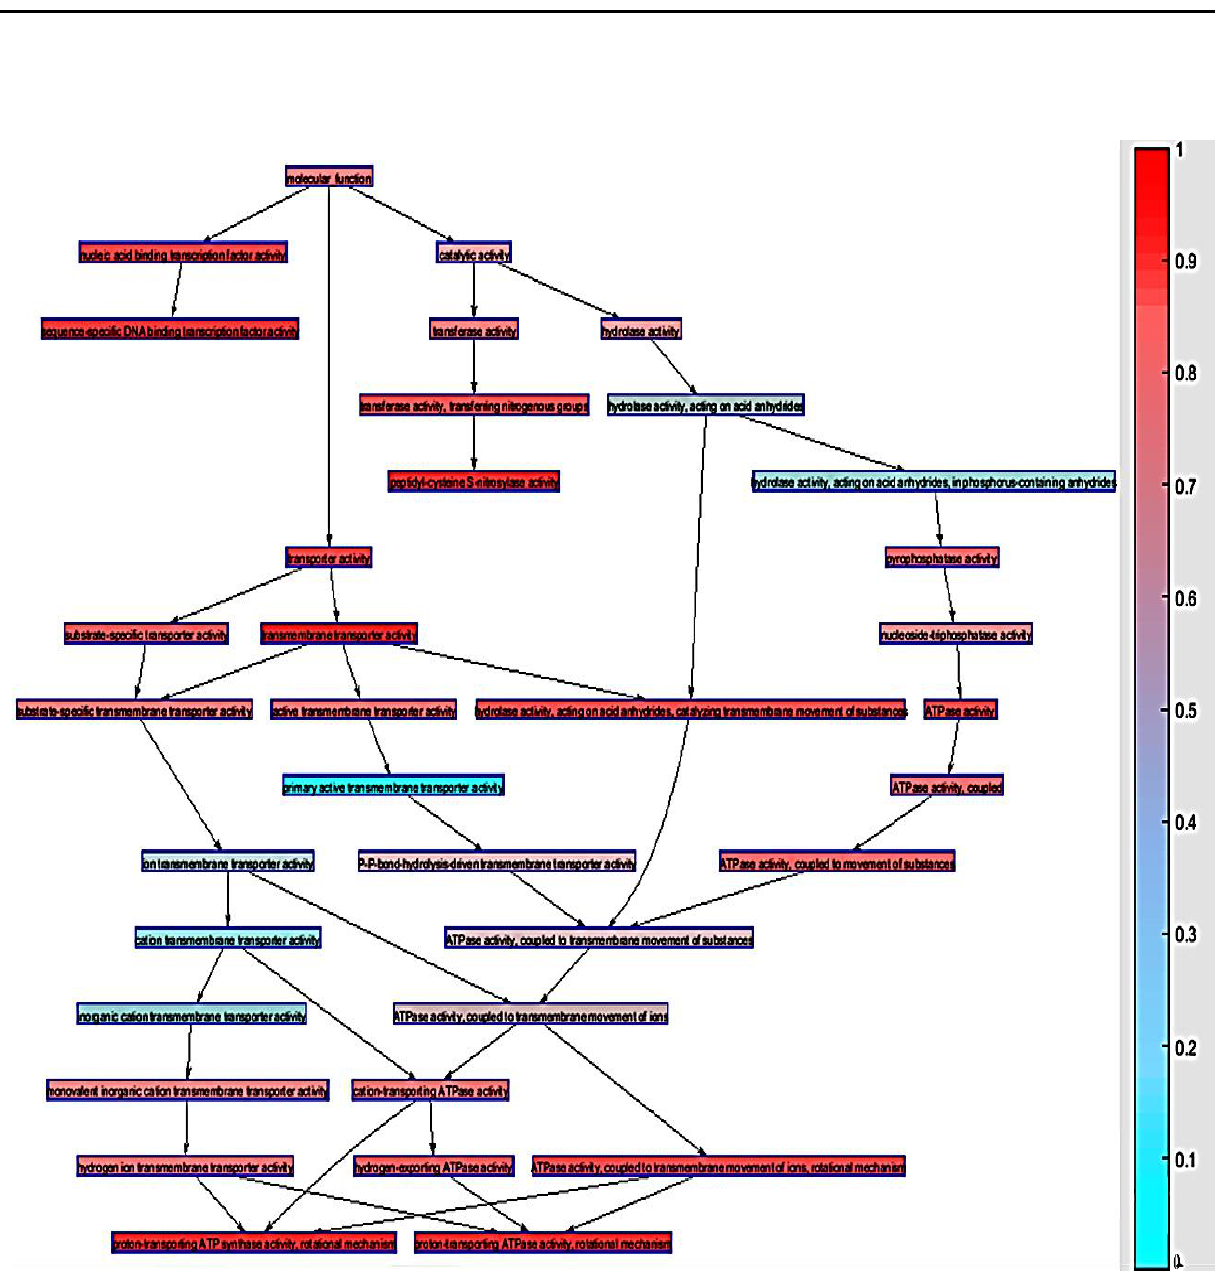
Figure 9. GO Annotation for Up-regulated genes Table 5. Resnik’s term similarity Table 6. Lin’s term